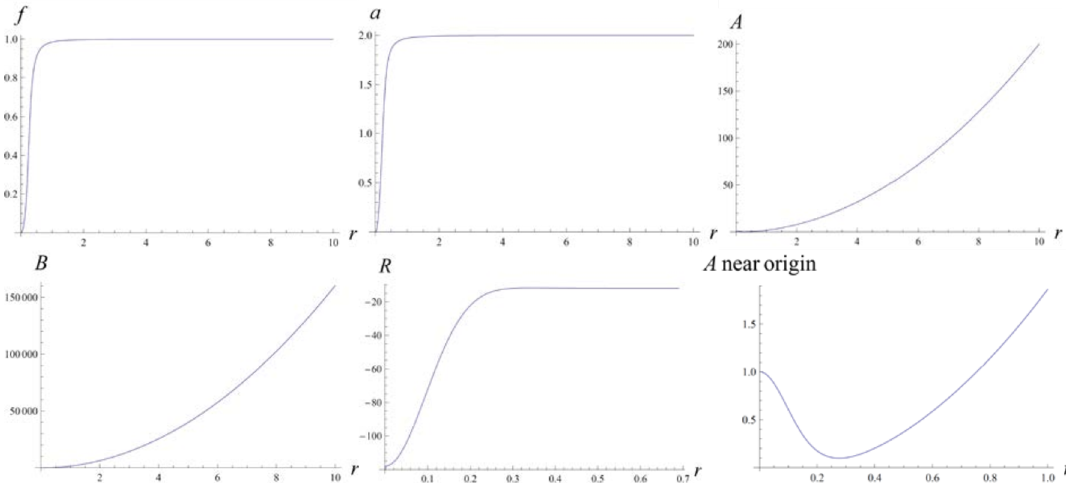
Figure 5 . Case V: n = 2 , v = 1 and Λ = − 2 . This case differs from all four previous cases because the winding number is now n = 2 instead of n = 1 (the function a plateaus at 2 now). It is the most massive case (considerably more than the first three cases and still greater than the v = 2 case). This reflects the n 2 dependence of the integral mass formula (3.12). Again, there is a significant dip in the metric A near the origin while it remains positive (no horizon). Near the core of vortex, the metric departs significantly from its asymptotic BTZ black hole